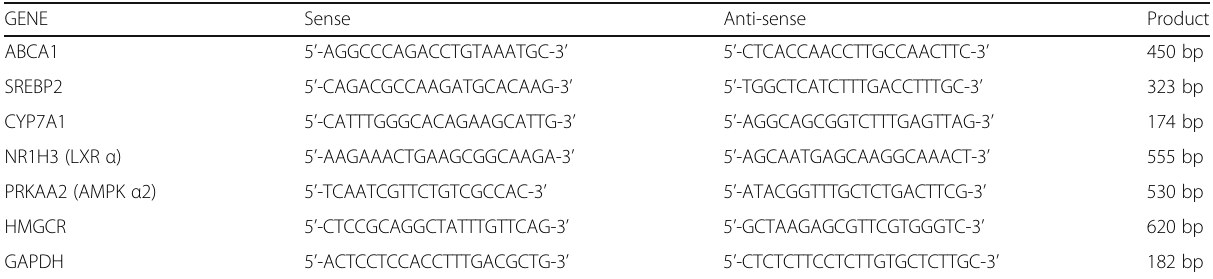
Table 1 The primers of gene